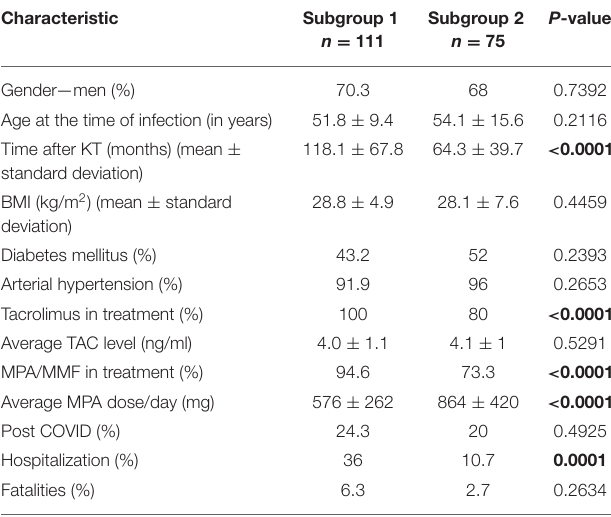
TABLE 5 | Basic group characteristics according to steroid dose/day.